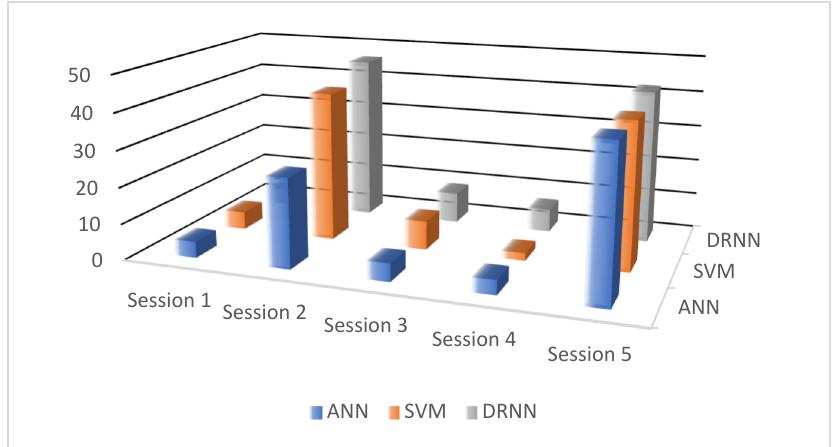
Table 3. Prediction performance under various sessions.